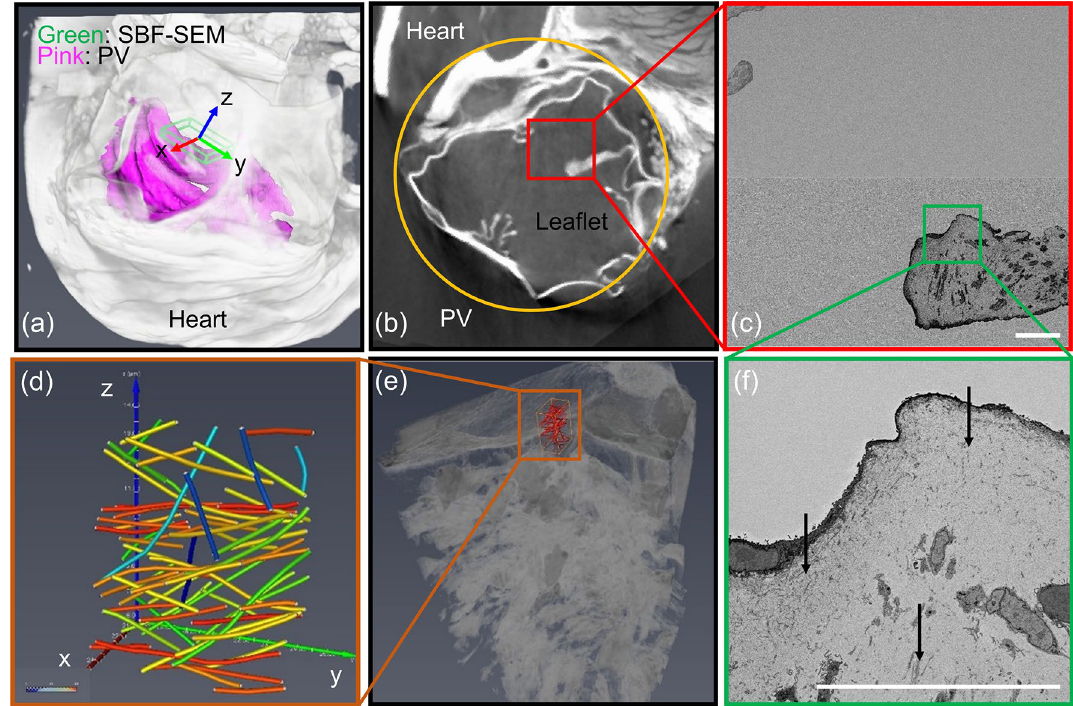
Figure 3. Representative images showing correlative imaging workflow. ( a ) μCT volume rendering of scanned region with a segmented PV at 20 mmHg (pink). Green bounding box (approximate dimensions of 450 × 600 × 60 μm) indicates total region imaged by SBF-SEM. ( b ) μCT volume rendering virtual slice where the PV is encircled in yellow and the red box represents the scanned area of ( c ), an image acquired by SBF-SEM. ( c ) Tiled low-resolution overview SBF-SEM micrographs of the right leaflet near the mid-point of the free edge where the green box represents the area scanned in ( f ). The contrast difference from in ( c ) indicates the two tiled and stitched micrographs. ( d ) Fiber analysis of collagen where the different colors correspond to the angular deviation from the z-axis, θ, of the SEM coordinate system which varies between 0° (blue) to 90° (red). ( e ) SBF- SEM volume rendering of detailed SEM micrographs (grayscale). Orange volume indicates subvolume where fiber (red) analysis of collagen was done. ( f ) High-resolution, detailed SBF-SEM micrograph showing ECM and cellular features. Black arrows indicate regions of collagen. Scale bars in panel ( c , f ) correspond to 40 μm.